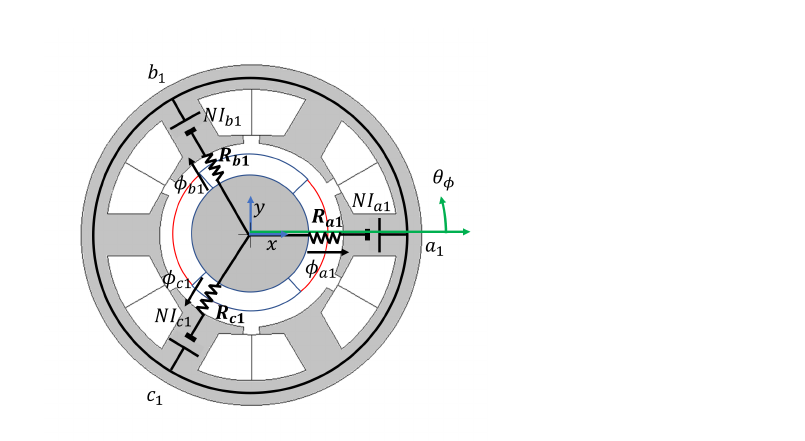
Figure 4. Simplified magnetic equivalent circuit of abc 1 based on air-gap reluctance.